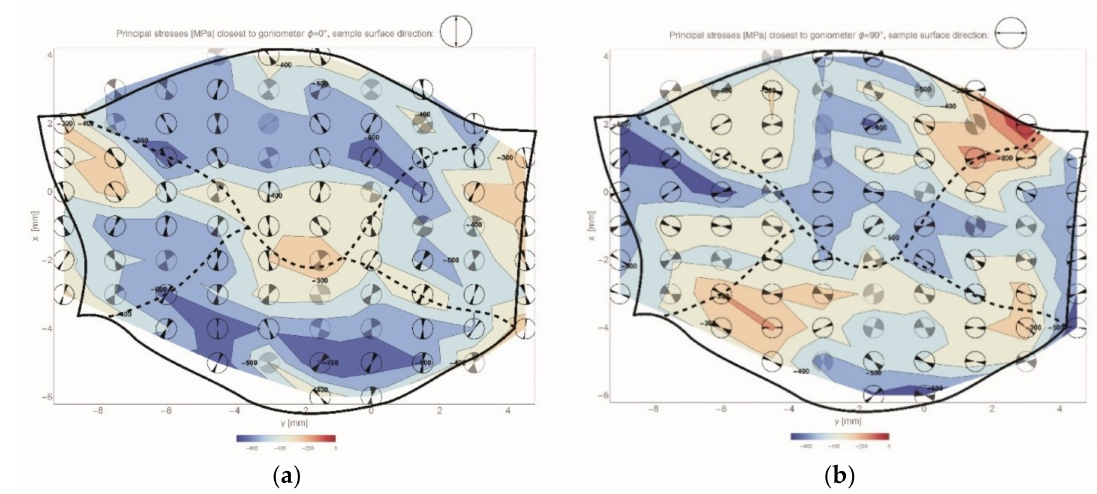
Figure 8. Residual stresses in WJ-S joint cross section in the form of projections of the principal stress vector in two directions: ( a ) vertical; ( b ) horizontal. The fusion lines are located by dashed